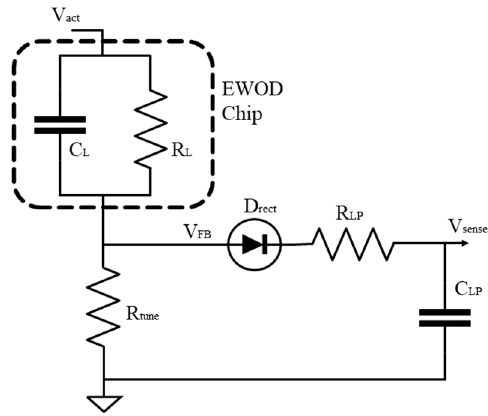
Figure 5. Position feedback circuit .